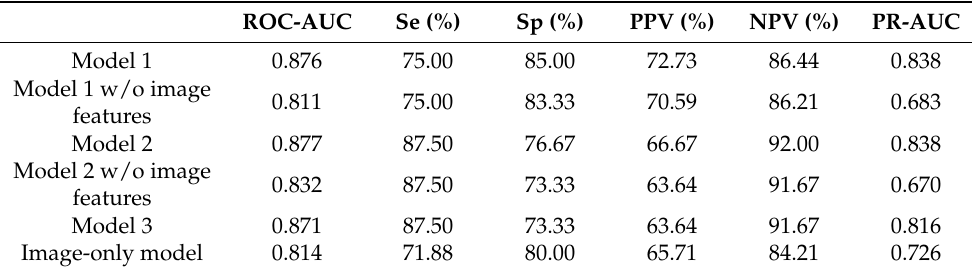
Table 3. Prediction performances of the screening